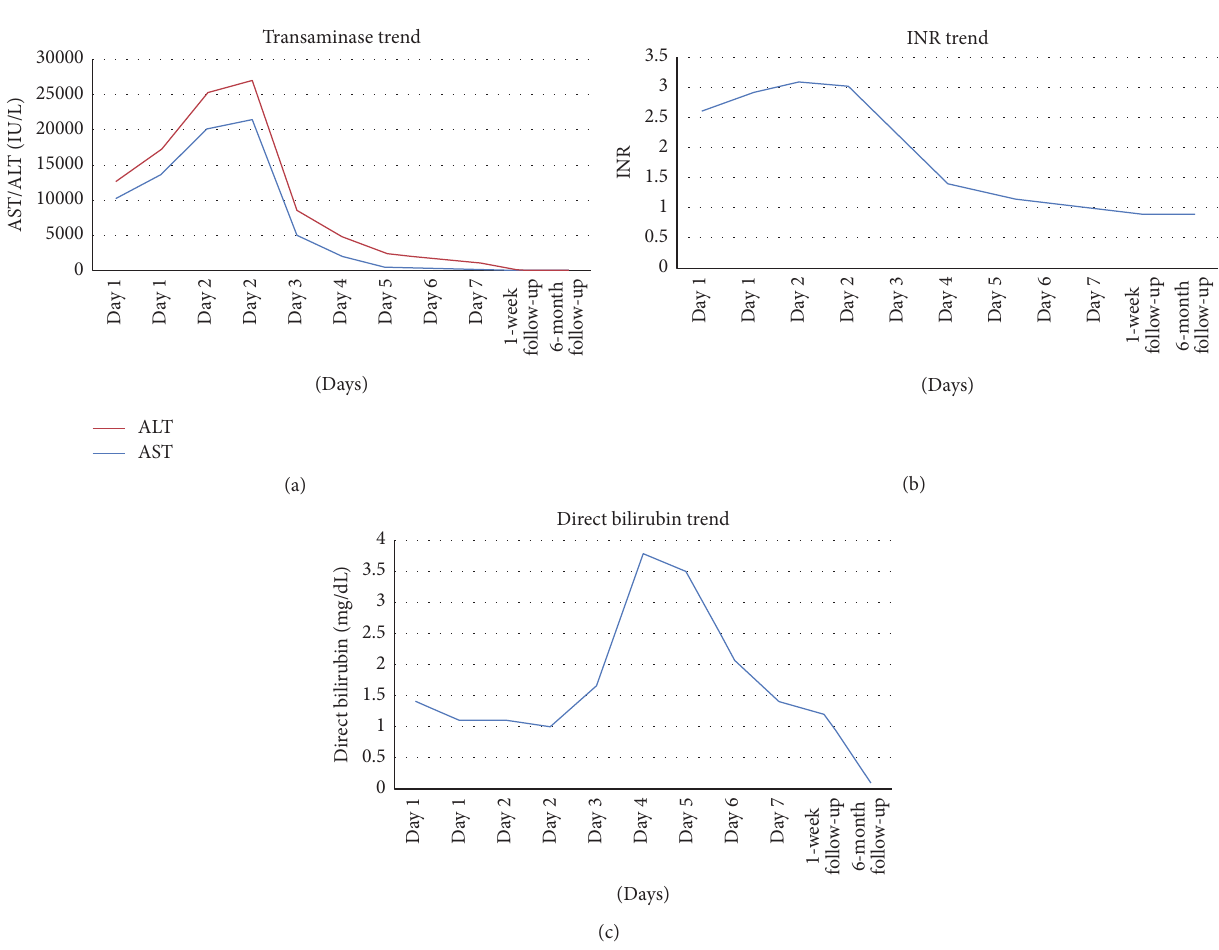
Figure 1: Linear graphs representing the trend of transaminases, INR, and direct bilirubin throughout patient’s hospital course and outpatient